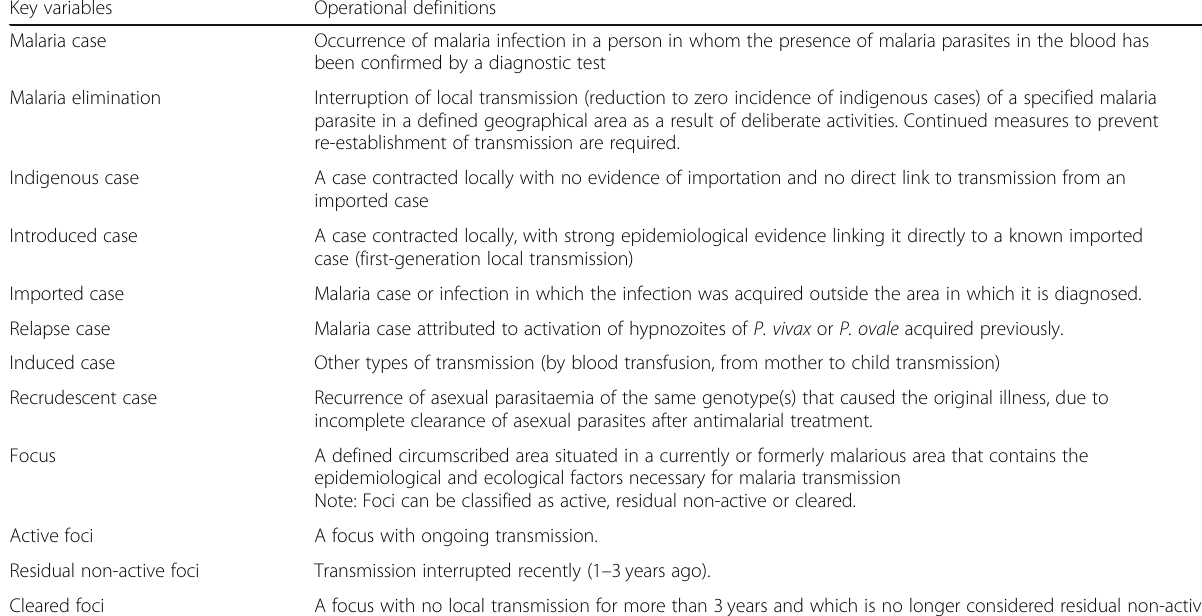
Table 5 Operational definitions of key knowledge